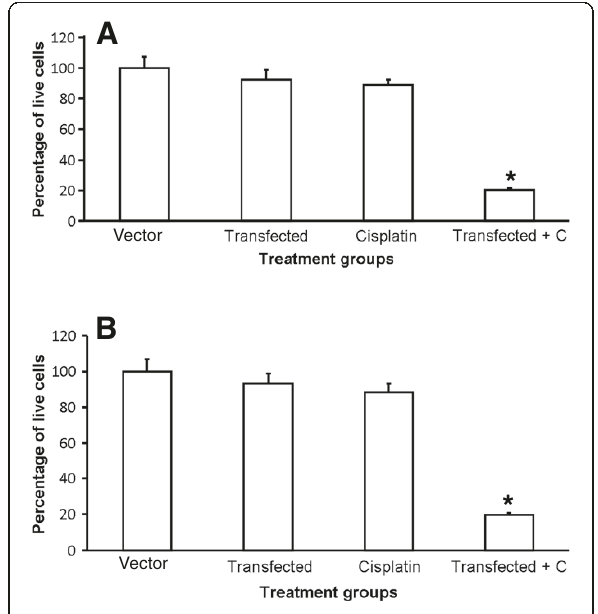
Figure 5 Effect of transfection with sFRP4 plasmid and subsequent Cisplatin treatment for 24 hours. ( A ) A2780-ADR live cell number following transfection with sFRP4 plasmid and subsequent Cisplatin treatment for 24 hours. ( B ) A2780-Cis live cell number following transfection with sFRP4 plasmid and subsequent Cisplatin treatment for 24 hours. Values represent means for each group ± SEM (* p < 0.001; one way ANOVA and LSD).